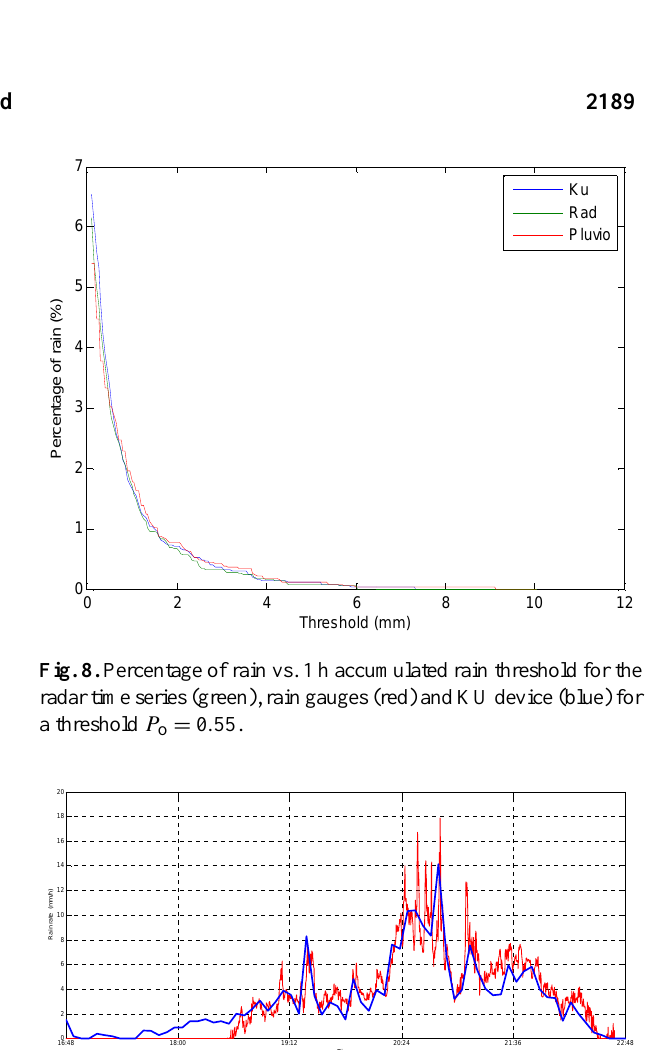
Fig. 9. Examples of time series recorded by the Ku device (red curve) and the radar (blue curve) .